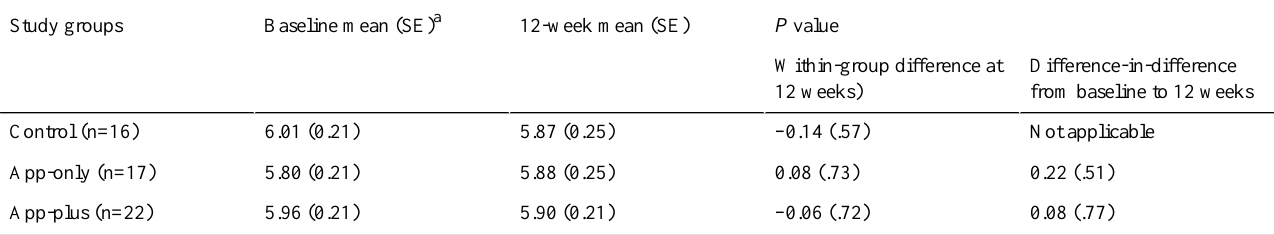
Table 2. Difference-in-difference analysis for autonomous motivation scores at 12 weeks compared with